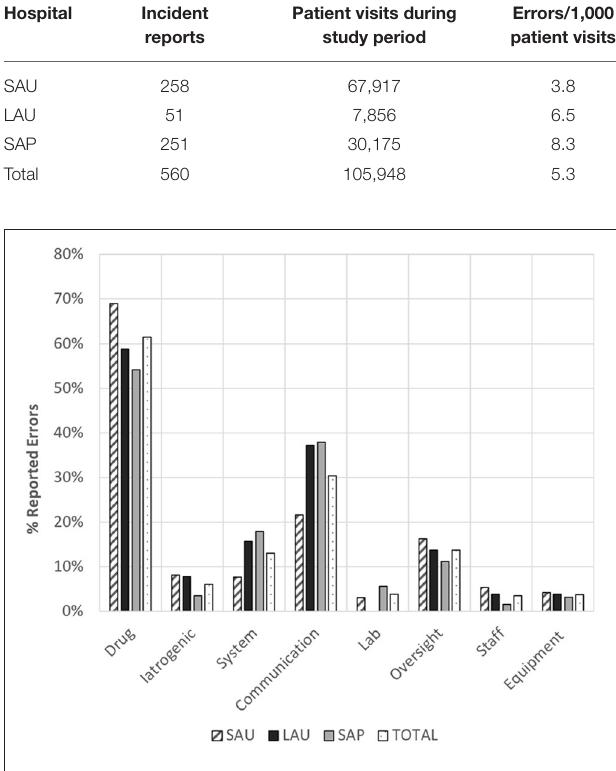
FIGURE 1 | Distribution of proportion of error types with respect to the total number in incidents reported in each of the three veterinary hospitals (NB: totals for a given hospital may be > 100% as multiple error types could be included in an incident report). SAU, small animal teaching hospital; LAU, large animal teaching hospital; SAP, small animal referral